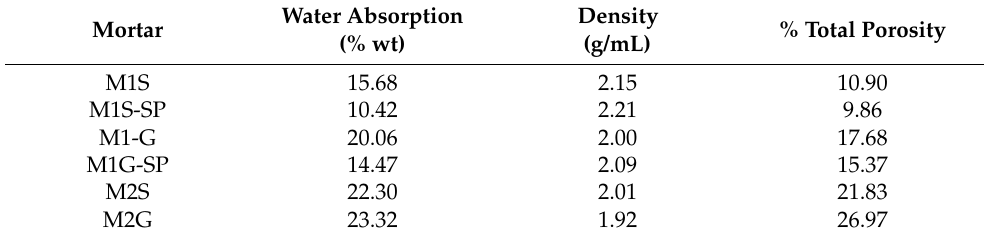
Table 8. Physical properties of 28 days